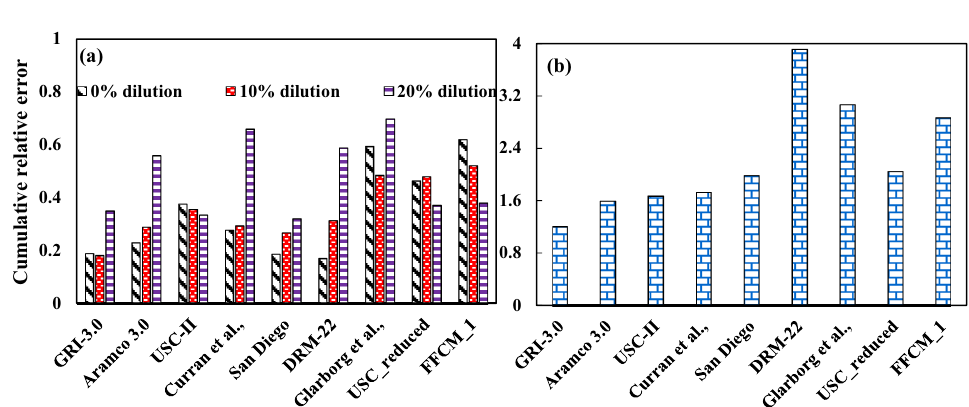
Figure 11. Cumulative relative error during the prediction of laminar flame speed ( a ) to show the effect of steam addition on error propagation using cases for Mazas et al. 37 and ( b ) for combined steam dilution cases adopted in literature 34,37,40